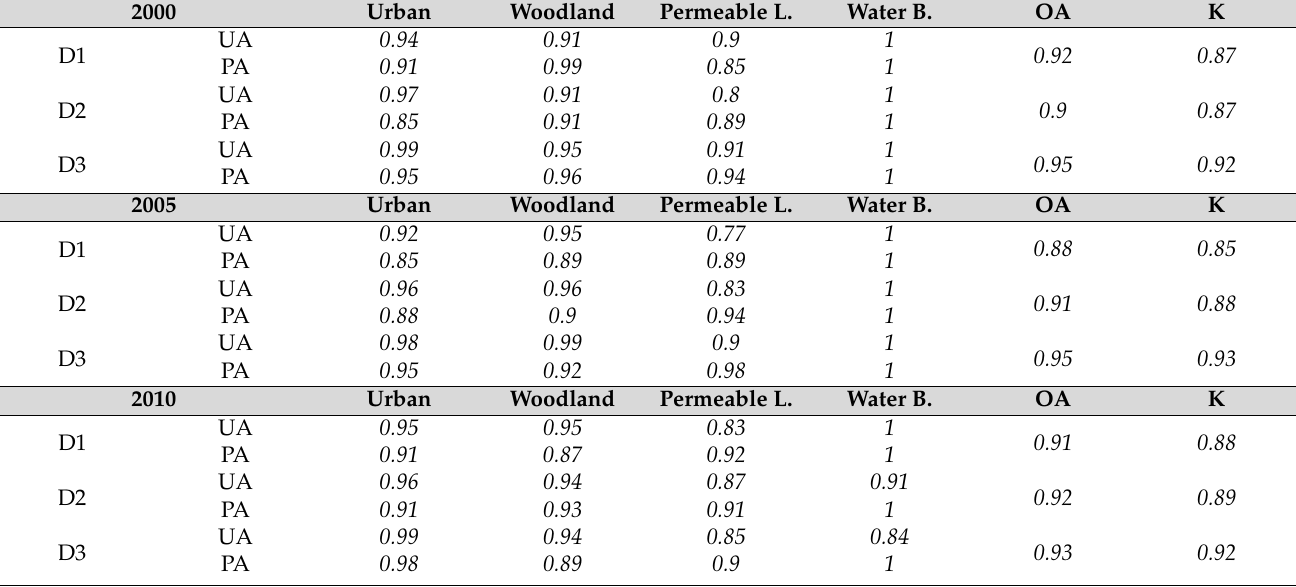
Table 4. Accuracy metrics of the different datasets derived from